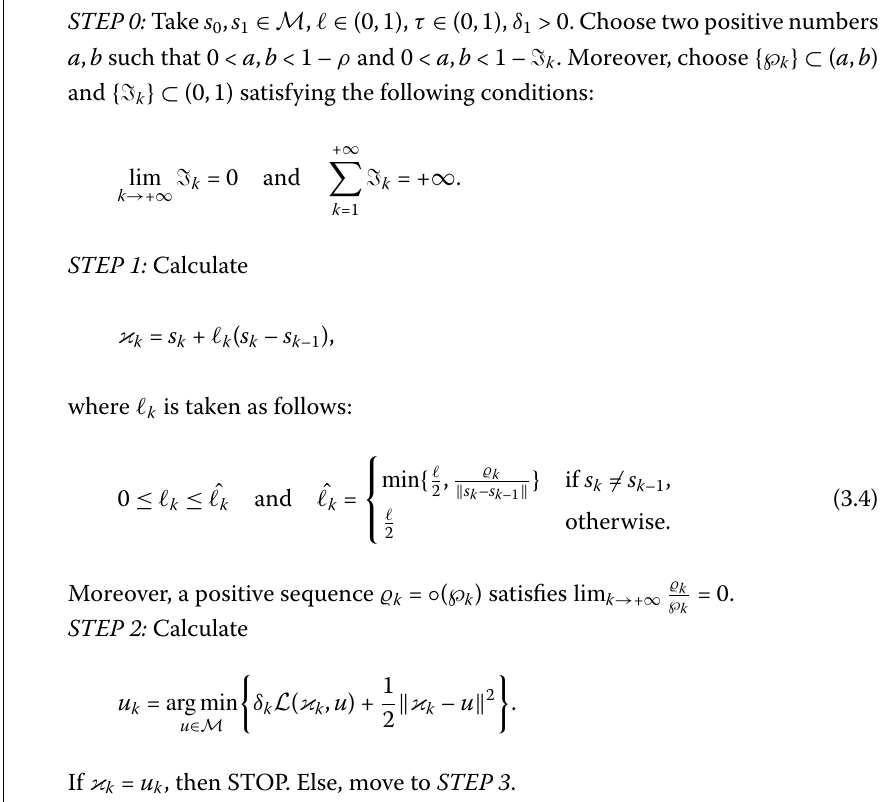
Algorithm 2 (Accelerated subgradient extragradient method with a nonmonotone step-size